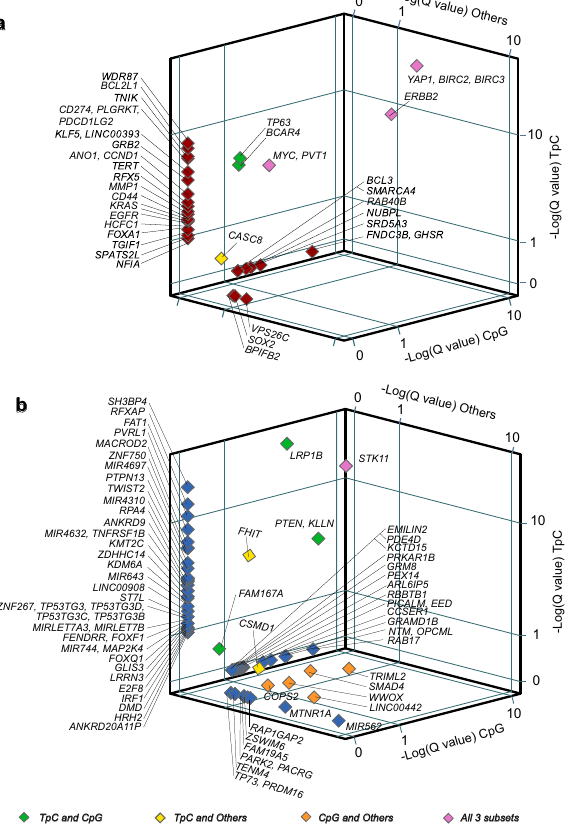
Fig. 4 Copy number alterations within 371 cervical carcinomas with predominantly TpC ( n = 245), CpG ( n = 87), and other ( n = 39) mutational pro fi les. Somatic copy number alterations were analyzed by GISTIC. 3D scatterplots showing the association between focal ampli fi cations ( a ) and deletions ( b ) in tumors with predominantly different mutational signatures. Negative equivalents of log-transformed Q values of each focal copy number alteration and the cancer-related gene(s) within that chromosomal peak/ region for TpC tumors ( y axis), CpG tumors ( z axis), and tumors with other mutational pro fi les ( x